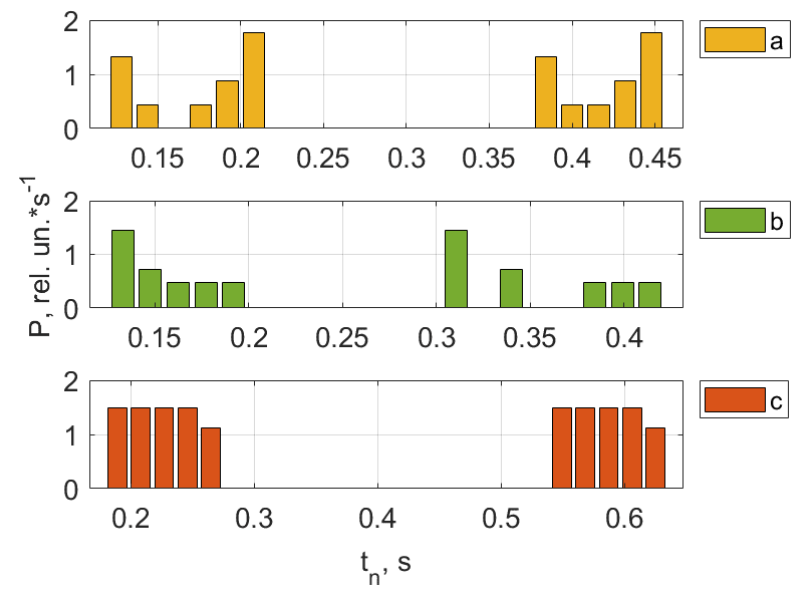
Figure 9. Pulse wave crest processing results. The first patient ( a ) is a 25-year-old man, ( b ) is a 28-year-old man, ( c ) is a 30-year-old man.